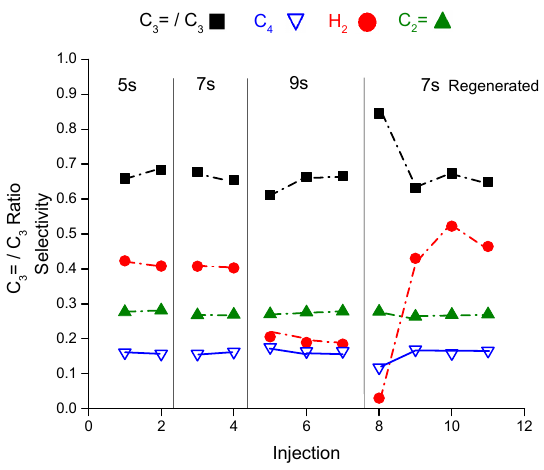
Figure A2. Detailed conversion values for injections at 460oC with different contact time, compared to injections after regeneration at the same conditions. Injection #1 done on fresh sample. (When compared to selectivity changes the conversion is not changing so significantly).